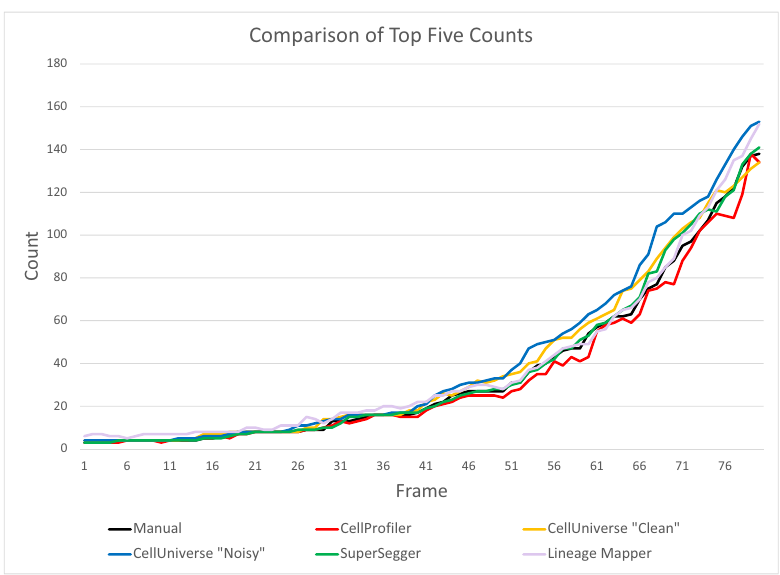
Figure 4. The comparison of the counts returned by the top four